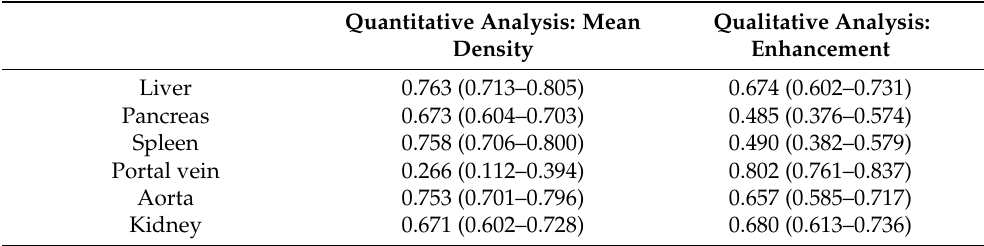
Table 2. Interreader agreement (intraclass correlation coefficient with 95% confidence interval) in the quantitative and qualitative image analysis parameters.